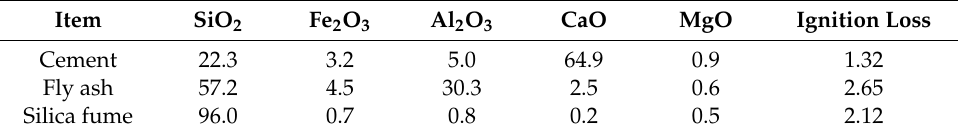
Table 2. Chemical compositions of cement, fly ash, and silica fume (wt.%).